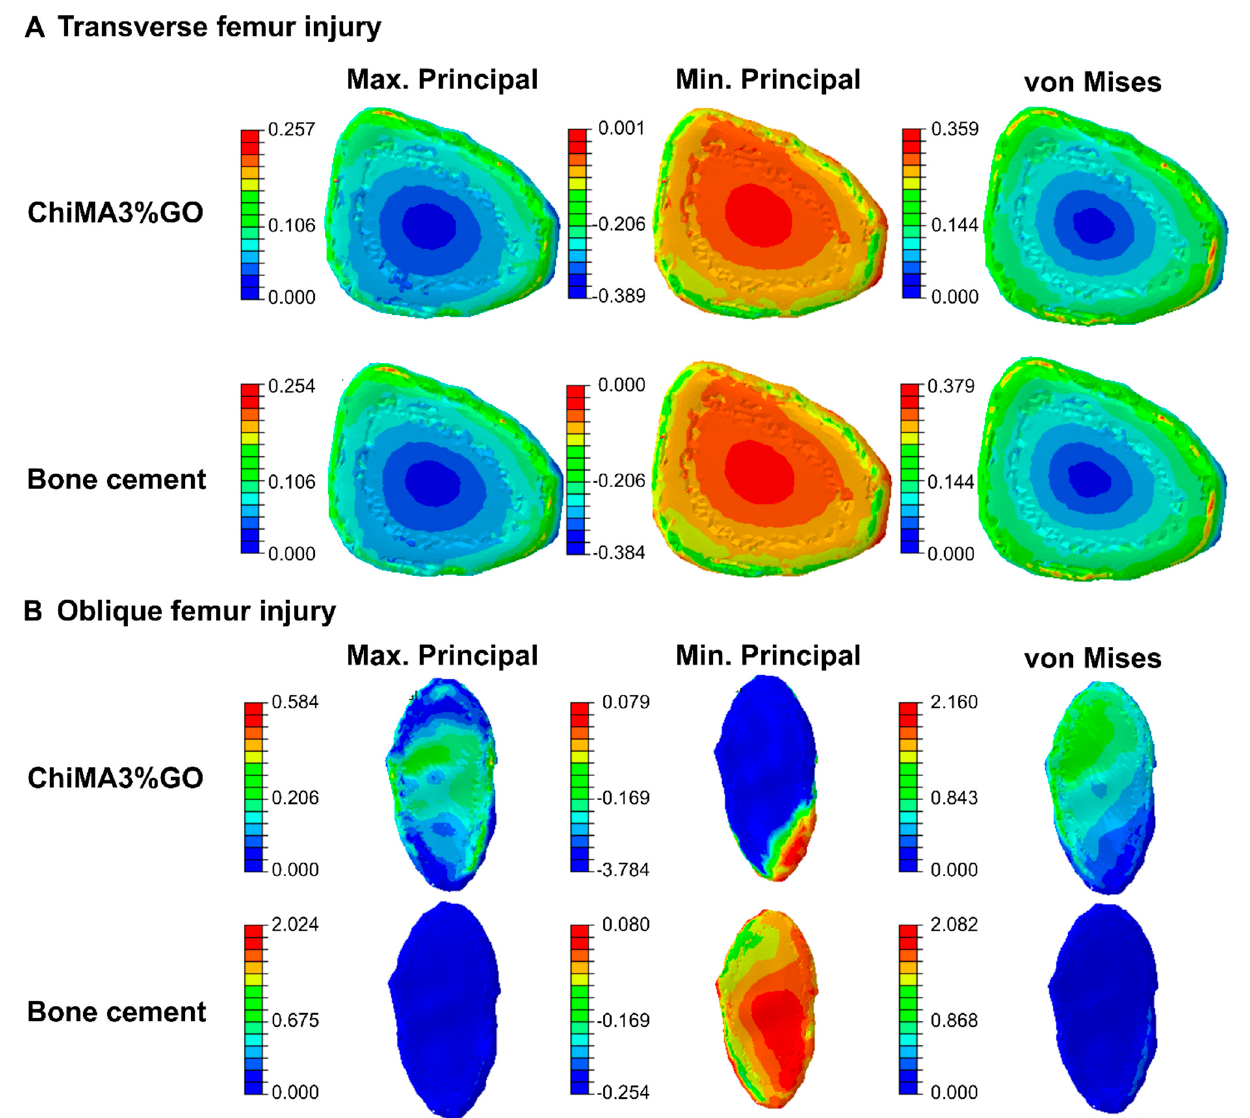
Figure 10. Distribution of tensile and compressive forces over ChiMA3%GO- and bone cement-repaired femurs under the effect of internal knee rotation. Maximum principal, minimum principal, and von Mises stresses are shown for ( A ) the transverse lesion and ( B ) the oblique